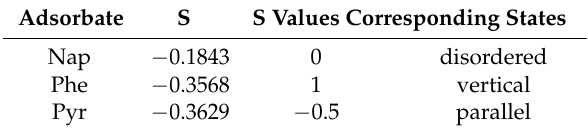
Table 1. Order parameter (S) for the molecular direction of Nap, Phe, and Pyr.